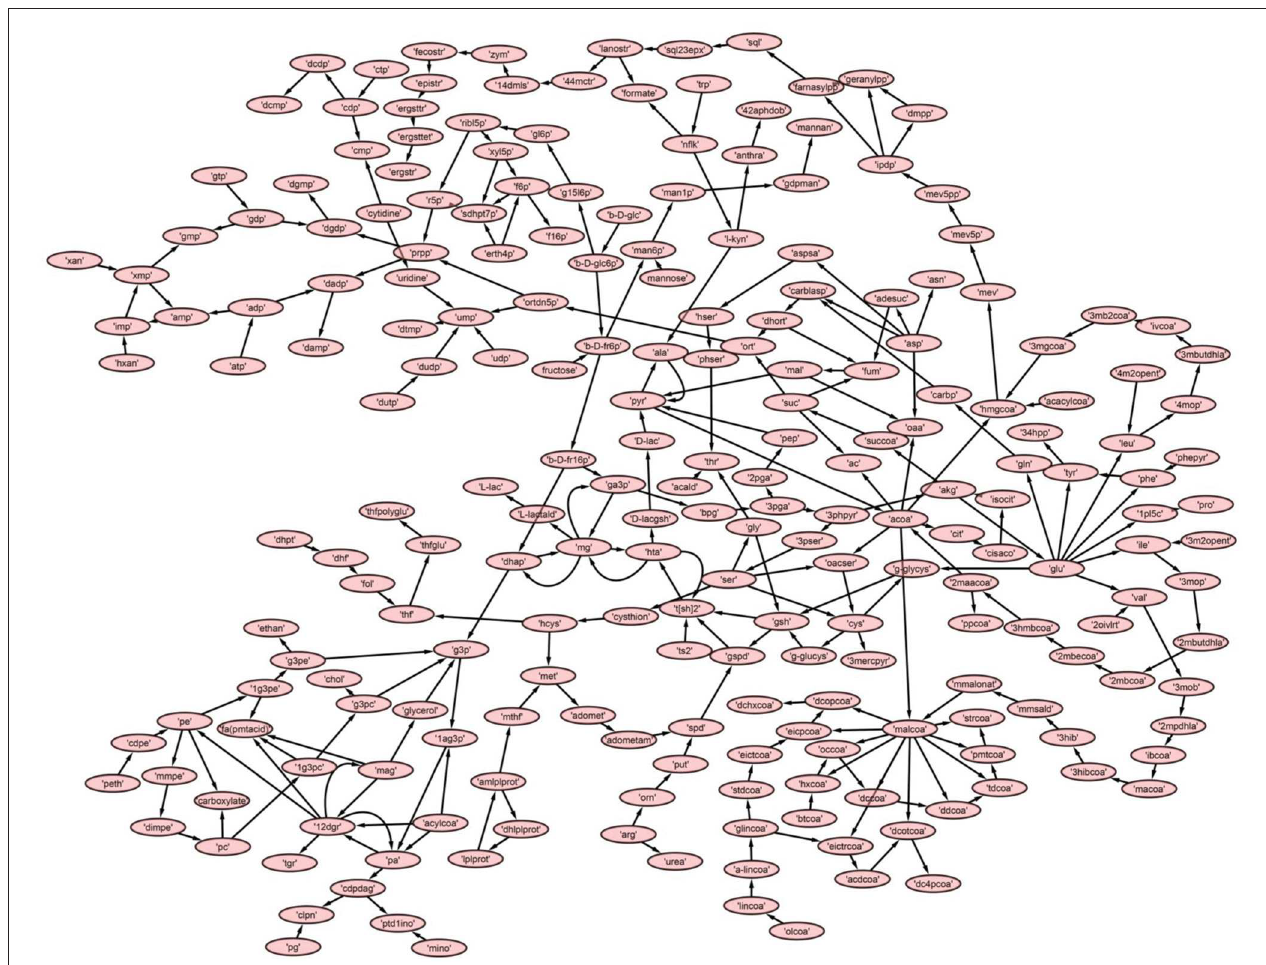
FIGURE 3 | The reconstructed master model, M, after removing currency metabolites and self-loops.